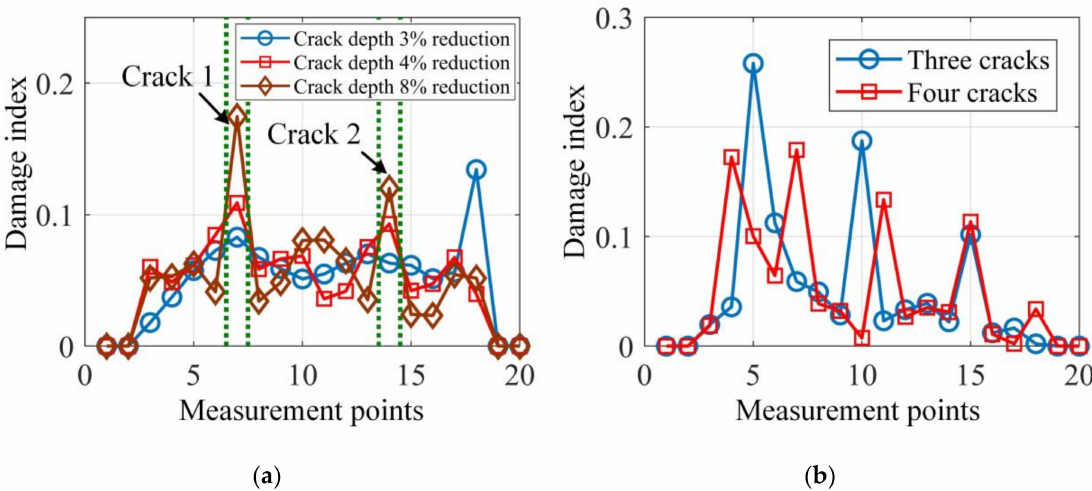
Figure 6. Nosie free damage localization results of ( a ) two cracks with di ff erent depth reductions and ( b ) di ff erent numbers of cracks with 10% depth